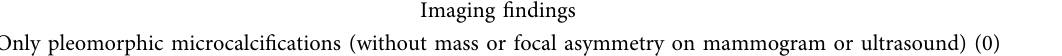
Table 1: Sono-mammometry score.